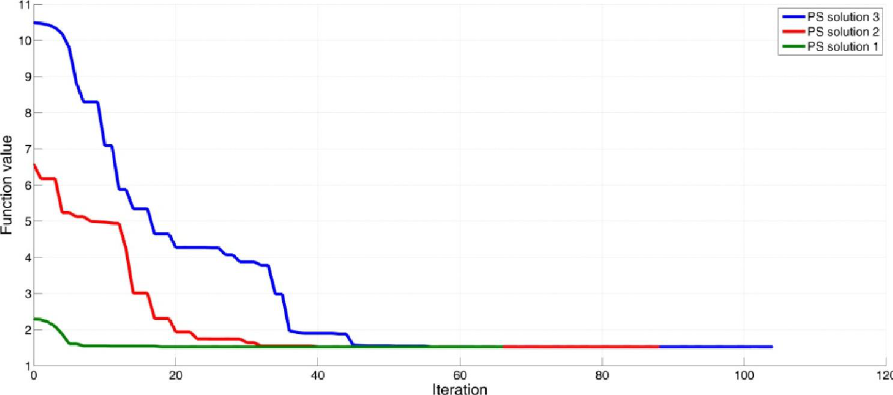
Fig. 1. Convergence of the PS algorithm